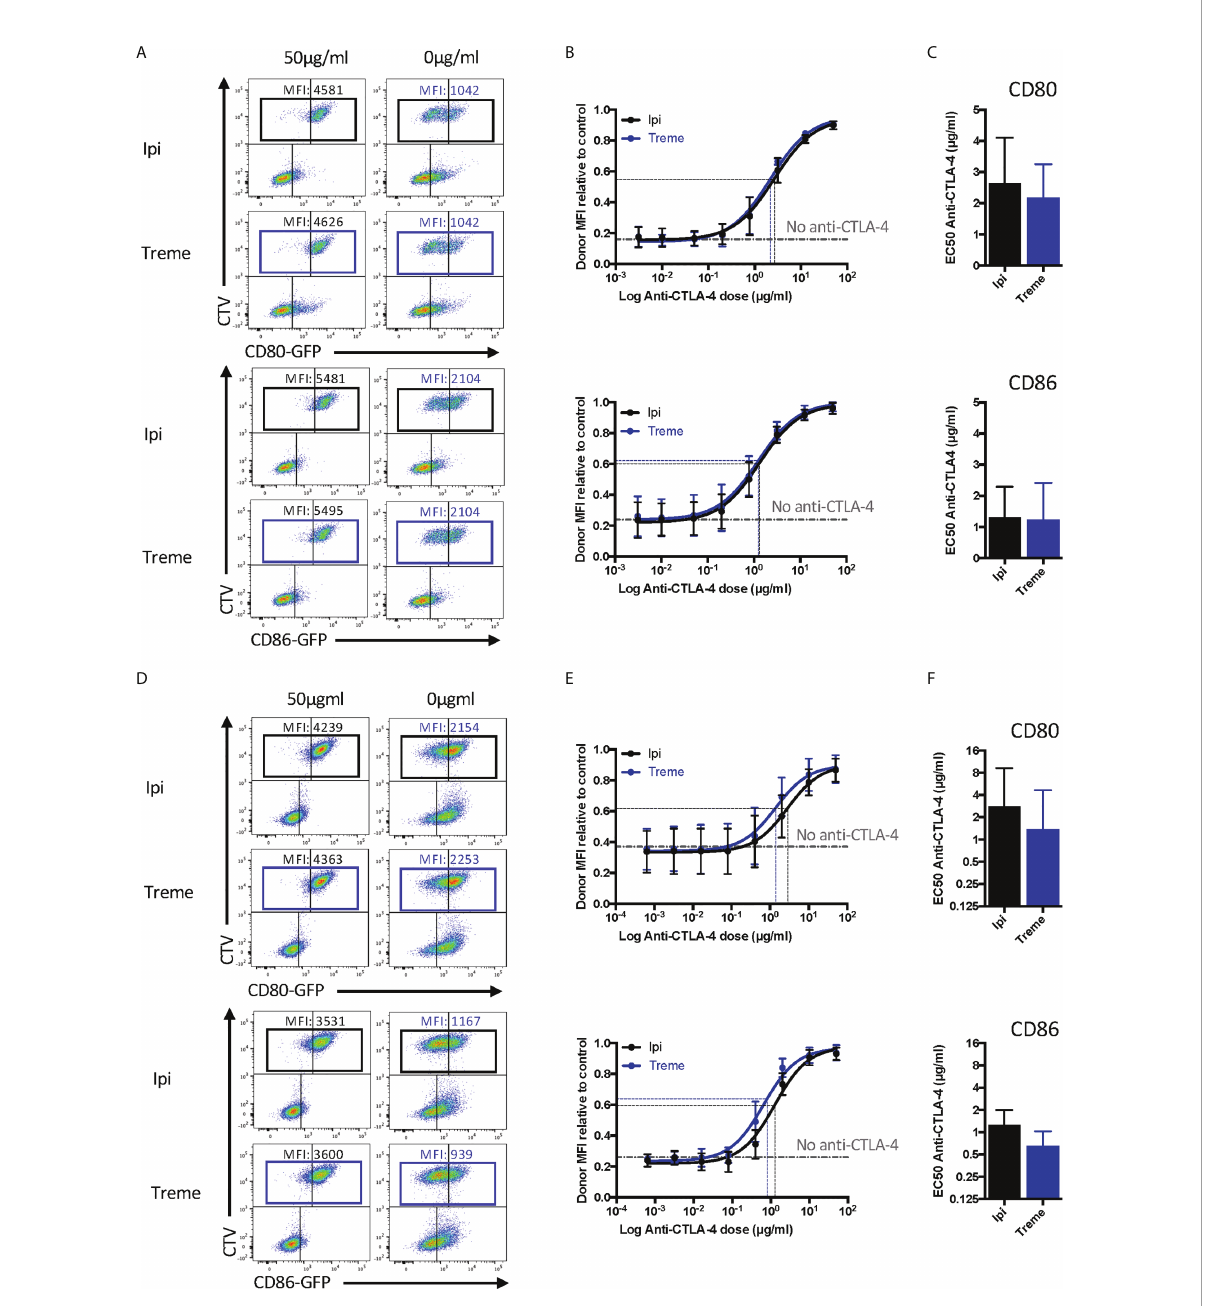
FIGURE 7 Ipilimumab and Tremelimumab block CD80 and CD86 ligand loss for APC by transendocytosis. (A) CTV stained CHO cells expressing either CD80 or CD86-GFP were cultured in the presence of CHO cells expressing CTLA-4 at a 1:1 ratio for 5 hours at 37°C. A titration of soluble ipilimumab (Black line) or tremelimumab (Blue line) were added at 0h. Percentage of CD80 or CD86-GFP ligand loss from CTV+ CHO cells by transendocytosis was determined by making the GFP MFI of CTV+ CHO cells relative to a negative control where no CTLA-4 was present. (B) Anti-CTLA-4 doses were Log(x) transformed and dose response curves fi t using Prism v6 to obtain Log EC 50 for Iipilimumab (Black line) and tremelimumab (Blue line). (C) Graphs show the mean EC 50 with 95% con fi dence interval calculated using Prism v6. (D-F) As in A, B & C except with CTLA-4 expressing Jurkat and CTV stained DG75 B cells expressing CD80 or CD86-GFP. Data for ipilimumab and tremelimumab were acquired in separate 96-well plates, data presented as mean +/- SD from 3 independent